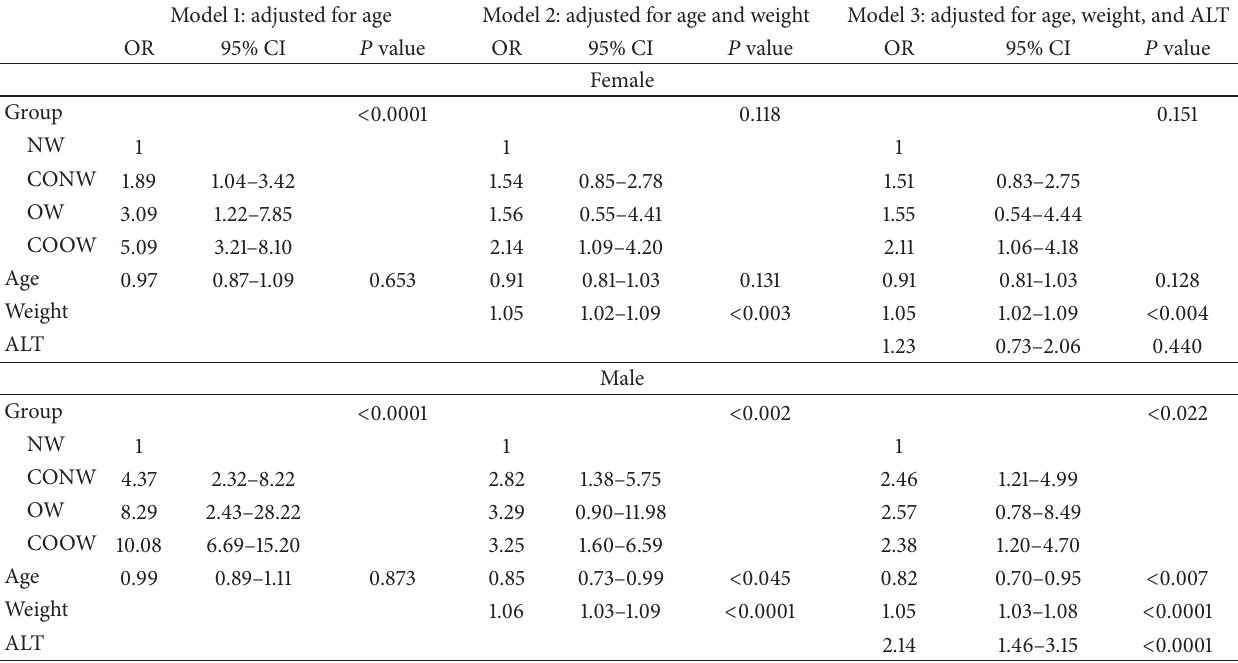
Table 5: Multivariate logistic regression analyses of having high insulin resistance among body composition groups. Model 1: adjusted for age Model 2: adjusted for age and